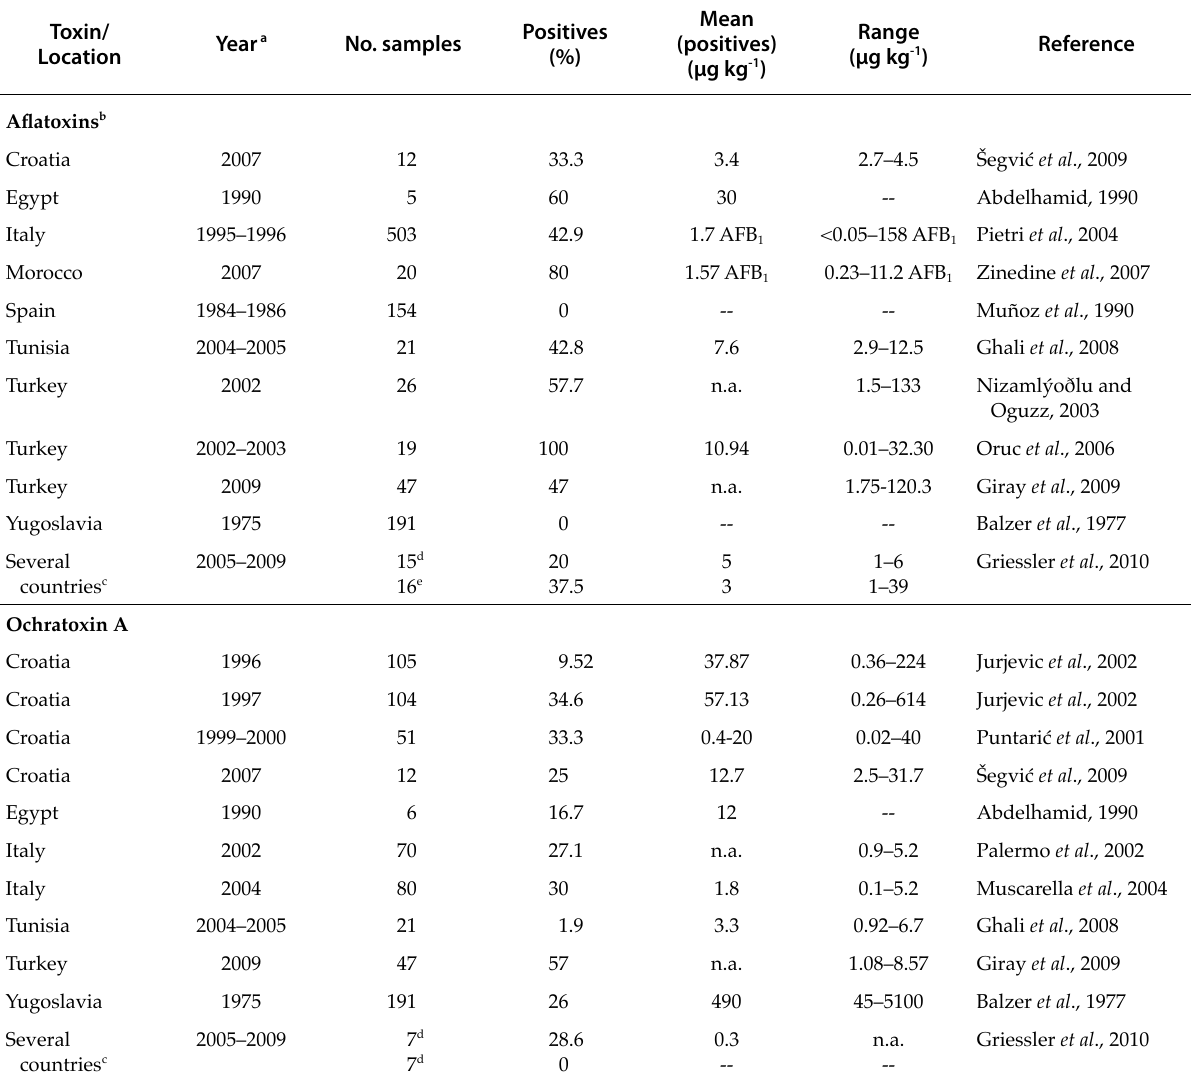
Table 5. Occurrence of aflatoxins and ochratoxin A in postharvest maize and maize-based products from Mediterranean